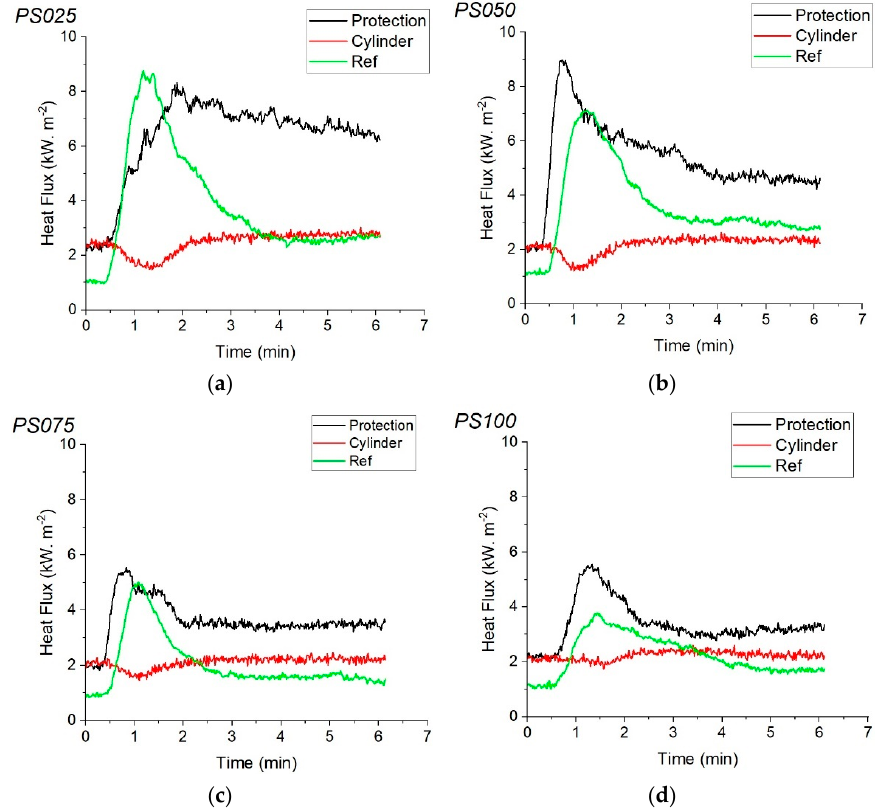
Figure 4. Heat flux on the protection, cylinder, and reference tests at ( a ) 0.25, ( b ) 0.50, ( c ) 0.75, and ( d ) 1 m from the basket fuel.